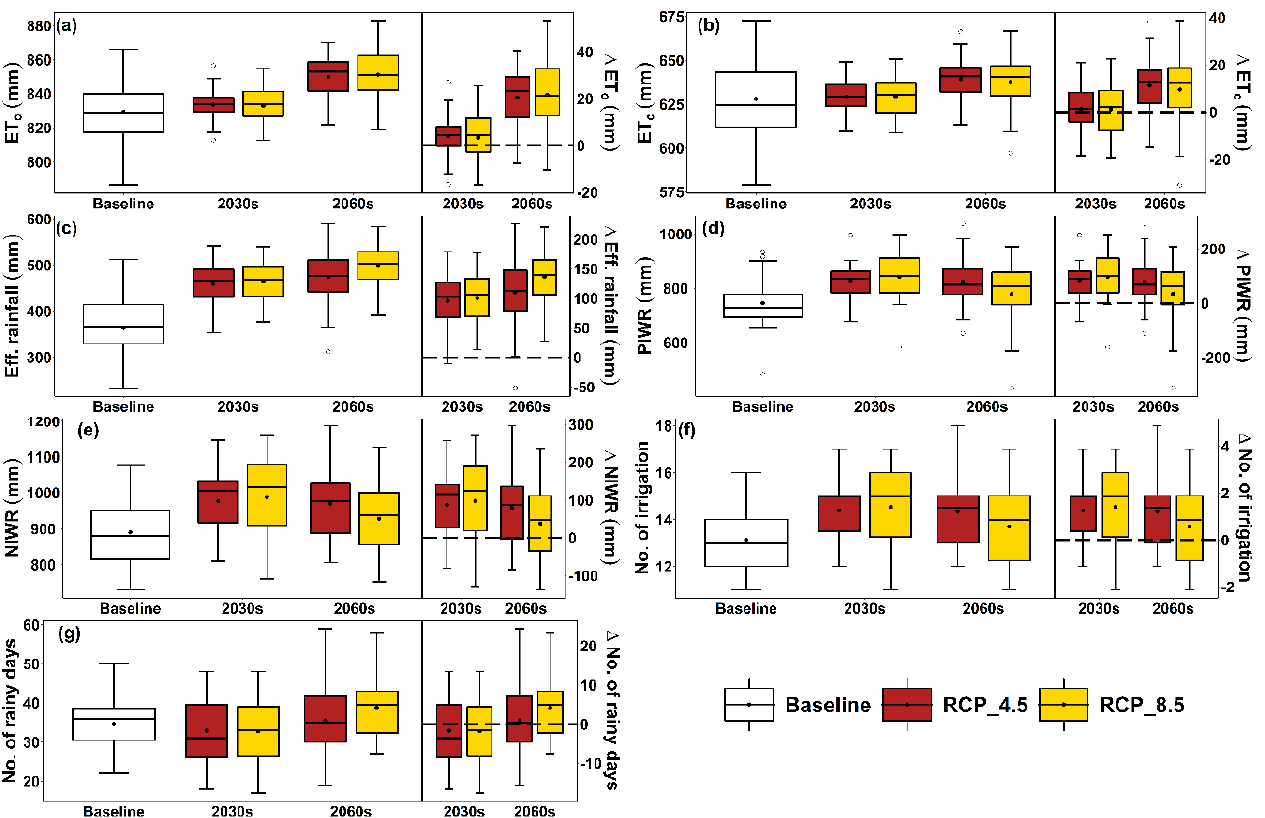
Figure 7. Rice seasonal (May–October) cumulative ( a ) reference evapotranspiration (ET o ), ( b ) crop evapotranspiration (ET c ), ( c ) effective rainfall (ER), ( d ) potential irrigation water requirement (PIWR), ( e ) net irrigation water requirement (NIWR), ( f ) number of irrigations, and ( g ) number of rainy days (N) during the baseline (1980 − 2010), 2030s (2021 − 2050), and 2060s (2051 − 2080).